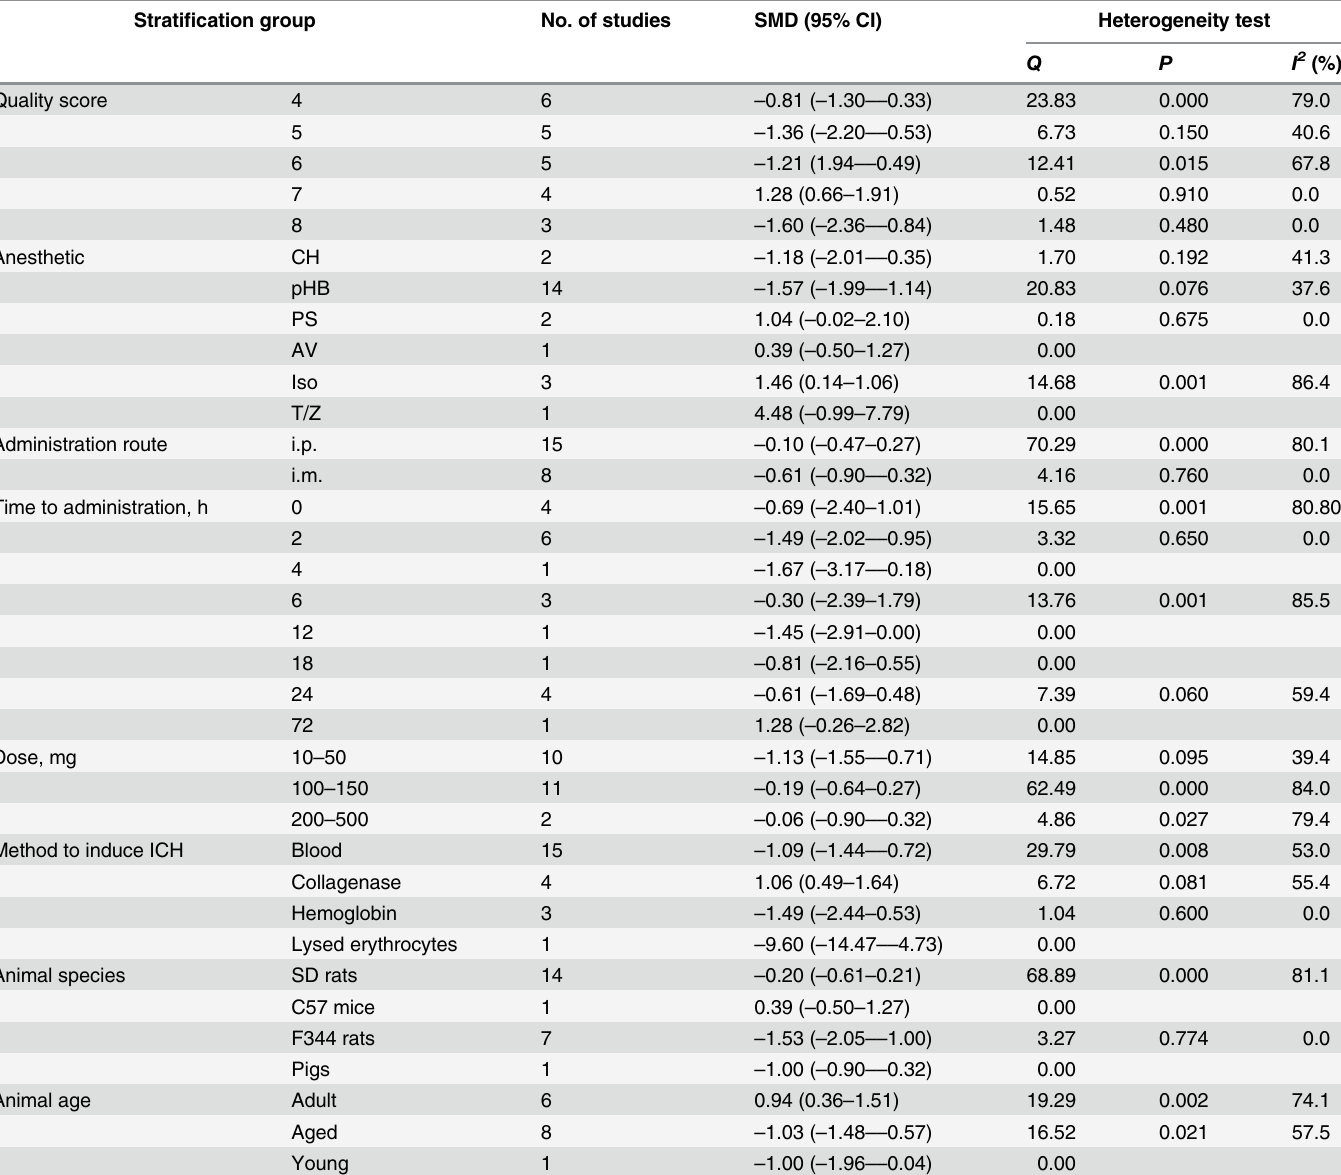
Table 3. Stratified meta-analysis of heterogeneity. Strati fi cation